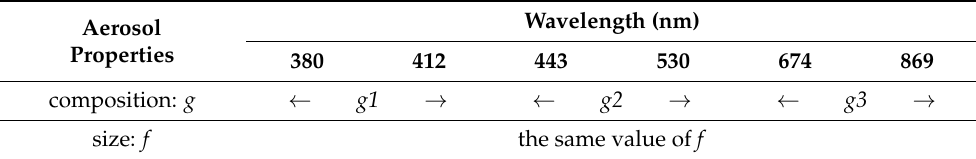
Table 1. Wavelength dependence of aerosol parameters used in this